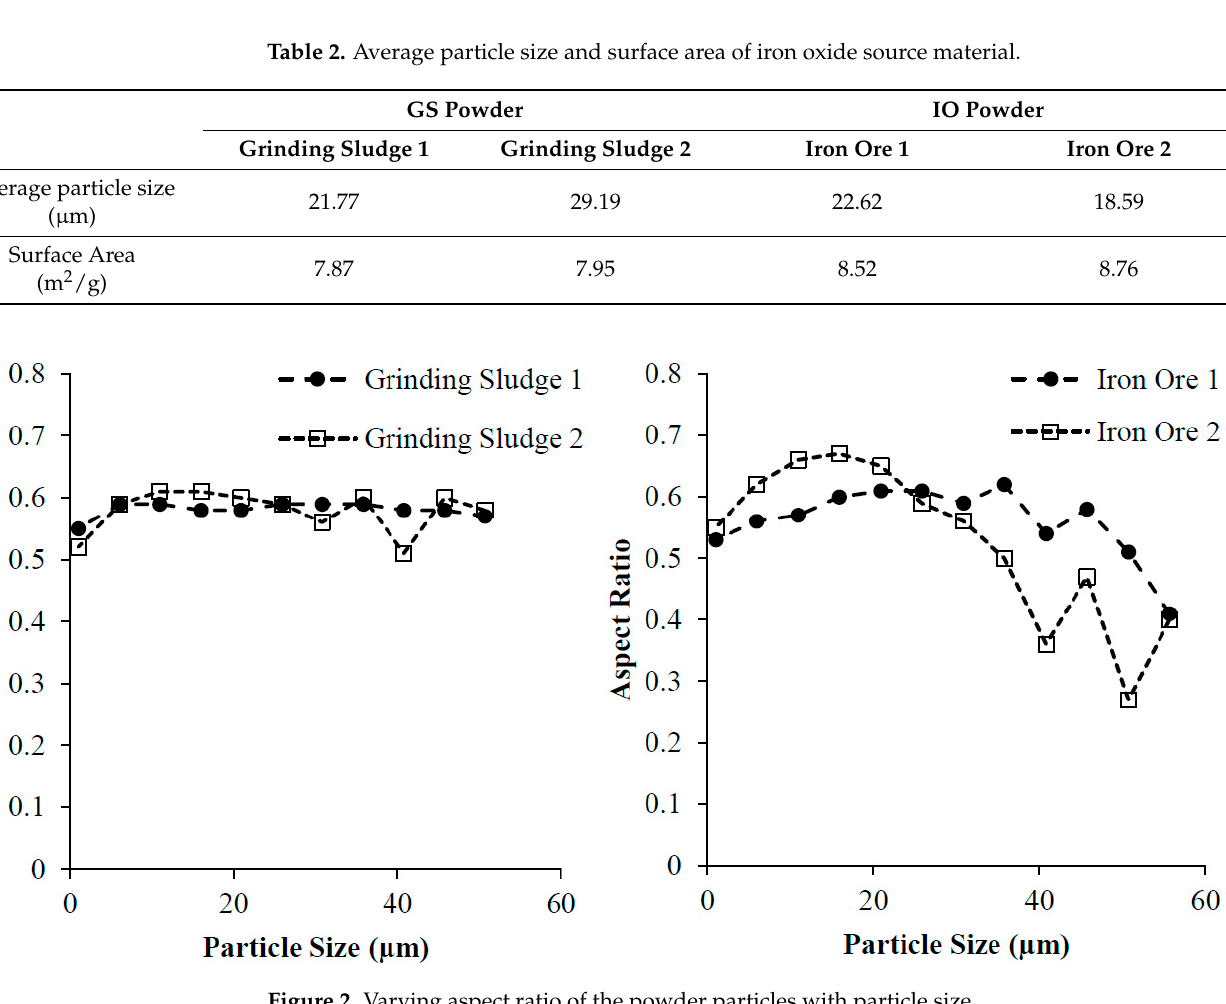
Figure 2. Varying aspect ratio of the powder particles with particle size.